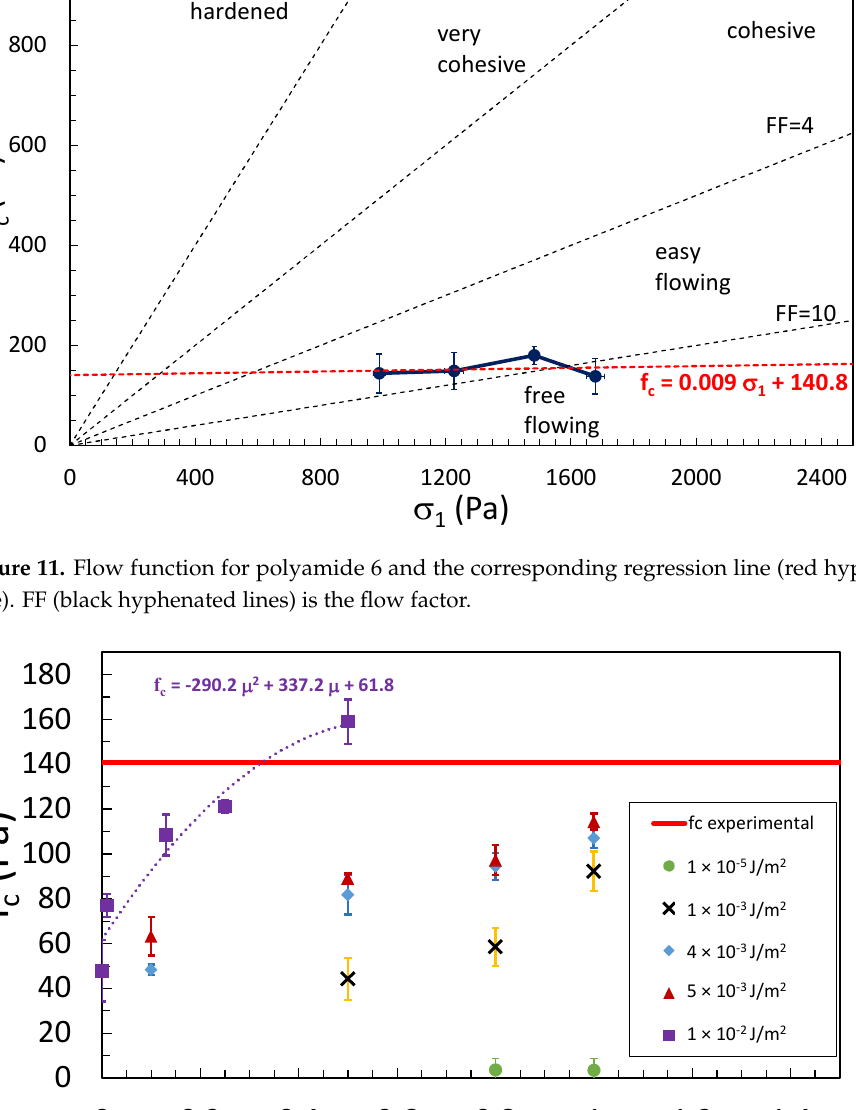
Figure 12. Unconfined yield strength, f c , as function of µ R, P − P for different values of Γ : • , 1 × 10 − 5 J/m 2 ; × , 1 × 10 − 3 J/m 2 ; ♦ , 4 × 10 −3 J/m 2 ; ▲ , 5 × 10 −3 J/m 2 ; ■ , 1 × 10 −2 J/m 2 . The continuous horizontal line corresponds to the experimental f c . The violet dotted line corresponds to the interpolating polynomial in case of Γ = 1 × 10 −2 J/m 2 .